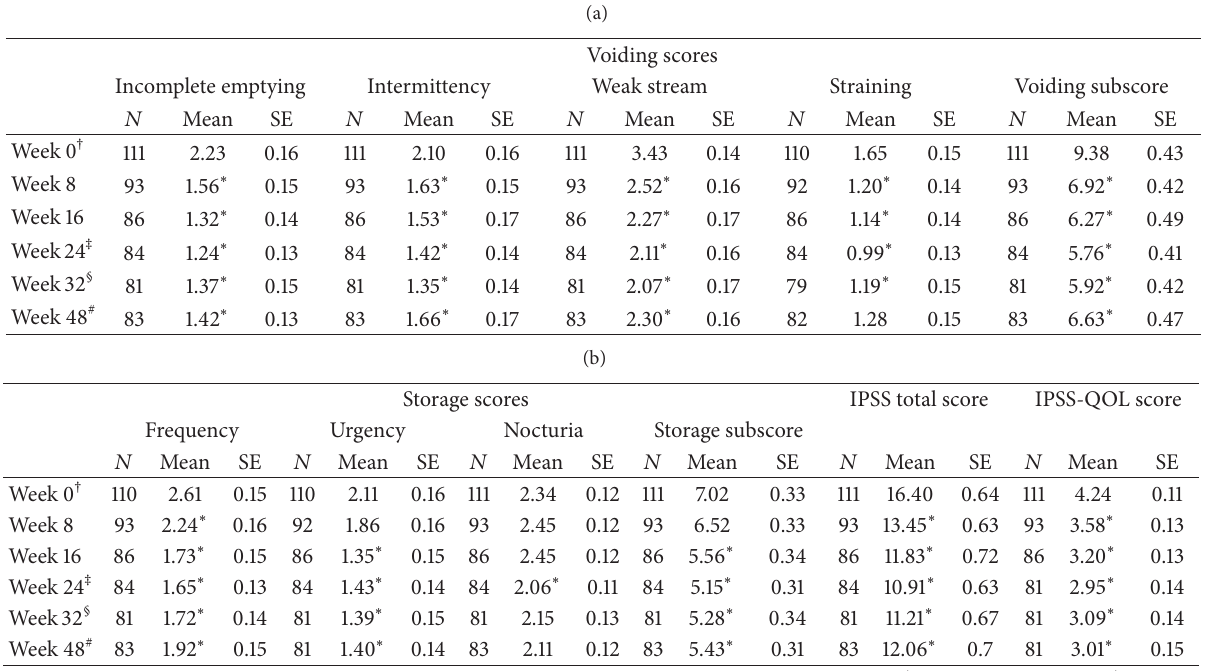
Table 2: International prostate symptom scores.